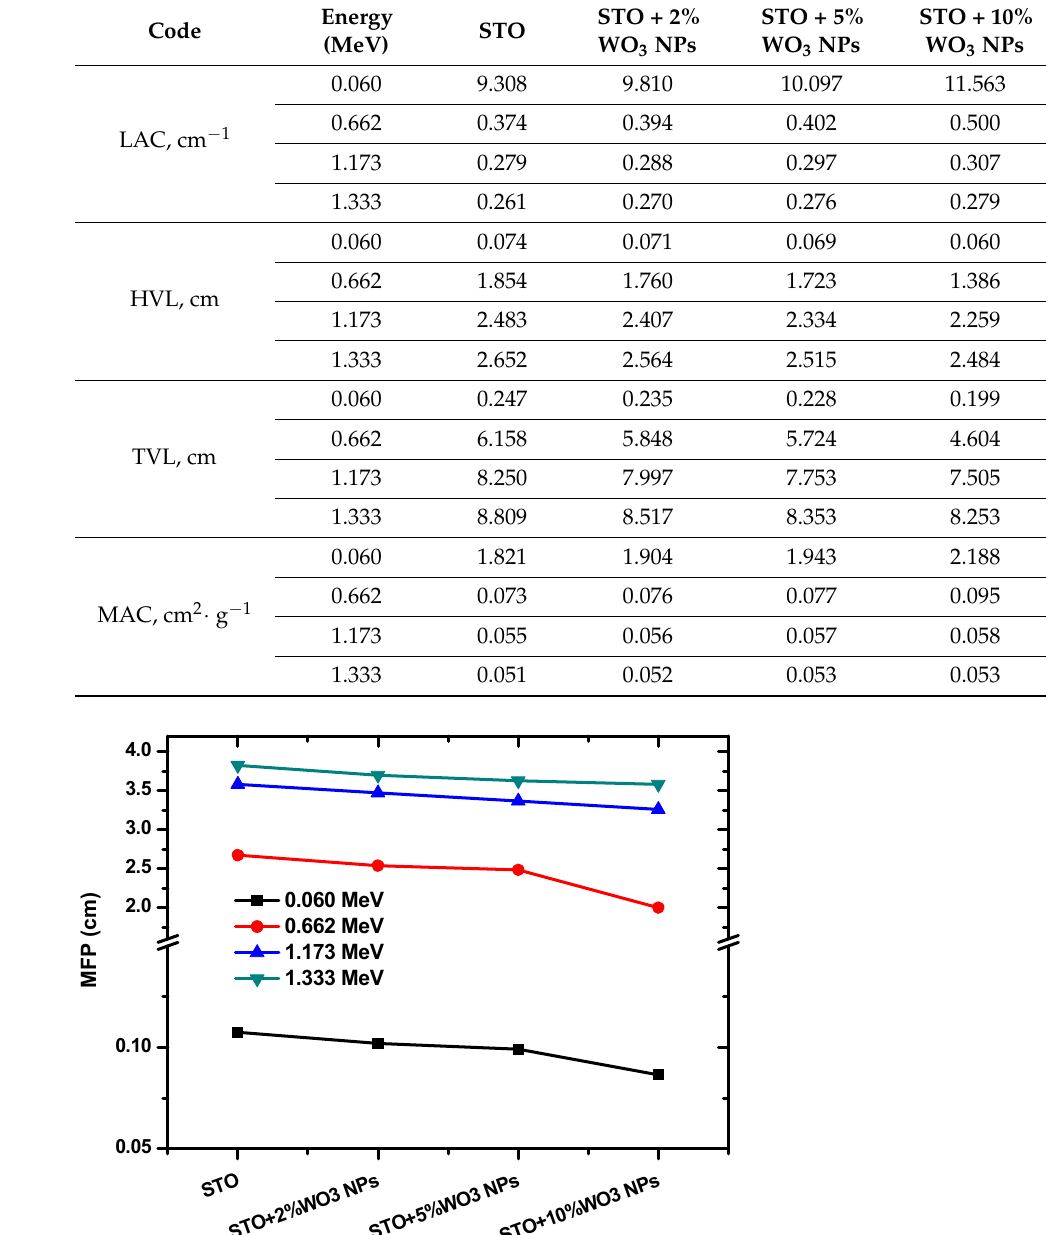
Figure 7. Mean free path of STO ceramic and STO ceramic doped with x% of WO 3 NPs. The radiation protection efficiency (RPE) of the four prepared STO ceramics was calculated and graphed in Figure 8 at a thickness of 0.5 cm. RPE increases with WO 3 content at all tested energies. For instance, at 1.333 MeV, the RPE values are 12.25%, 12.64%, 12.87%, and 13.02% for the samples with 0, 2, 5, and 10% WO 3 nanoparticles. A greater RPE indicates a more effective shielding capability, so raising the amount of WO 3 in the ceramics leads to greater attenuation. Furthermore, RPE decreases as the energy of the incoming photons increases. The RPE of the sample with no WO 3 is equal to 99.05 at 0.060 MeV and drops to 12.25% at 1.333 MeV. Meanwhile, the RPE of the sample with 10% of WO 3 nanoparticles is equal to 99.69% and 13.02% at 0.060 MeV and 1.333 MeV, respectively. This conclusion reinforces some of the results from the previous figures that more photons can be attenuated at lower energies.